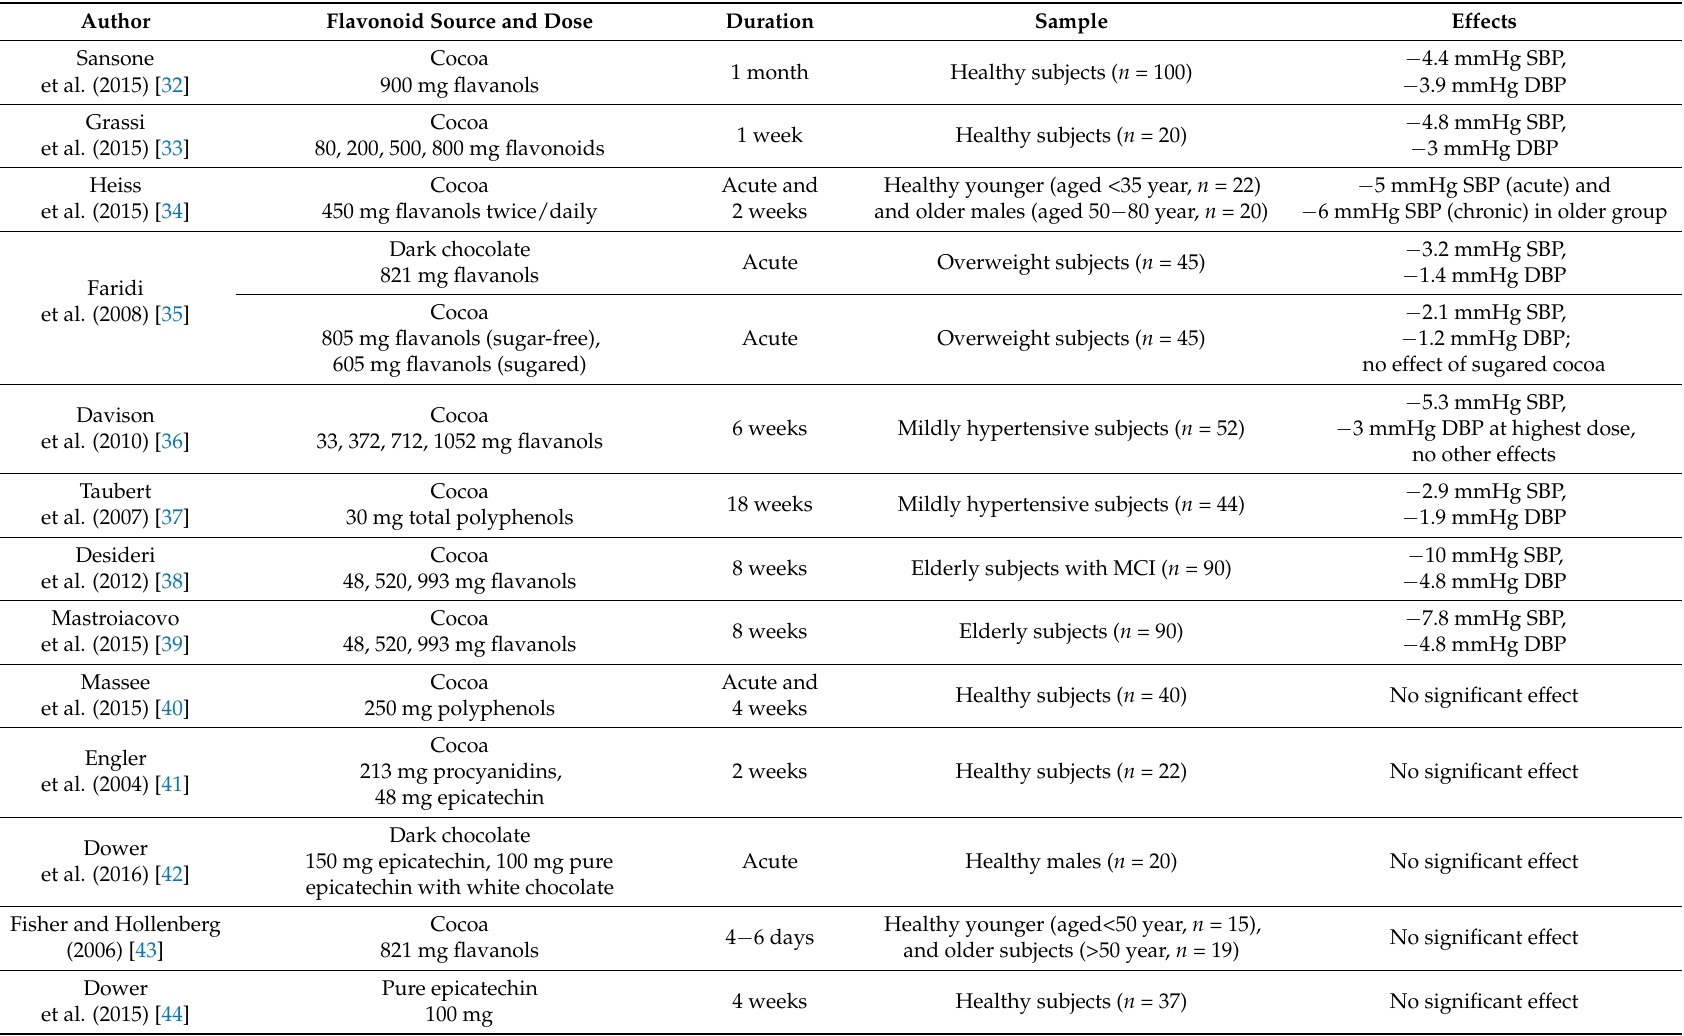
Table 1. Summary of studies investigating the effect of flavonoids on blood